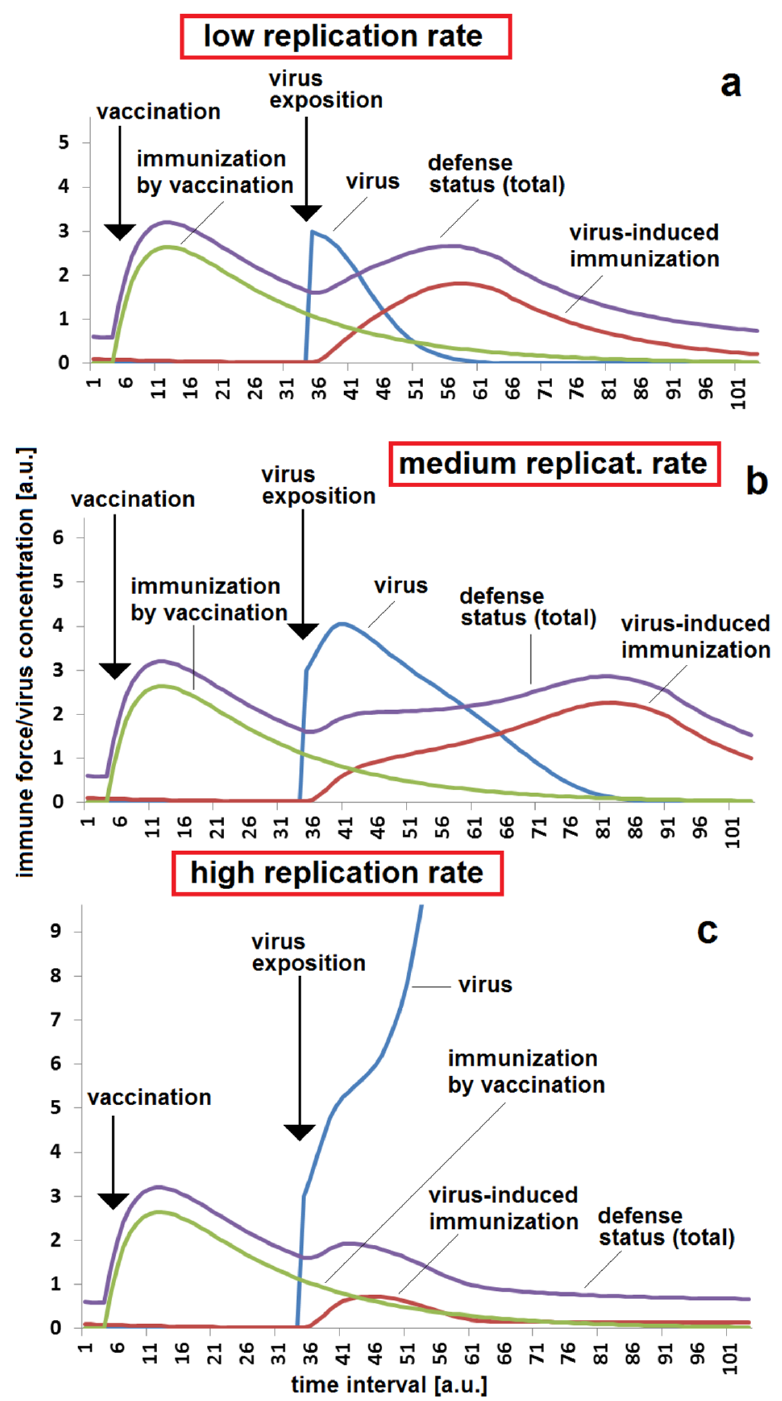
Figure 3. Immunization status, reaction and breakthrough of infection with respect to the virus replication rate in the case of a moderate time span between vaccination and virus exposition: ( a ) sufficient protection in the case of a low virus replication rate, k vir = 0.3; ( b ) stronger reaction and re-activation of immune response in the case of a medium replication rate, k vir = 0.5; ( c ) non-sufficient protection in the case of a high virus replication rate, k vir = 0.06. The set of other parameters for all three simulations ( a – c ): k r = 0.12; k st = 0.12; D vacc = 0.05; D AB = 0.05; c BGim = 0.5; v oo = 30; st oo = 10.